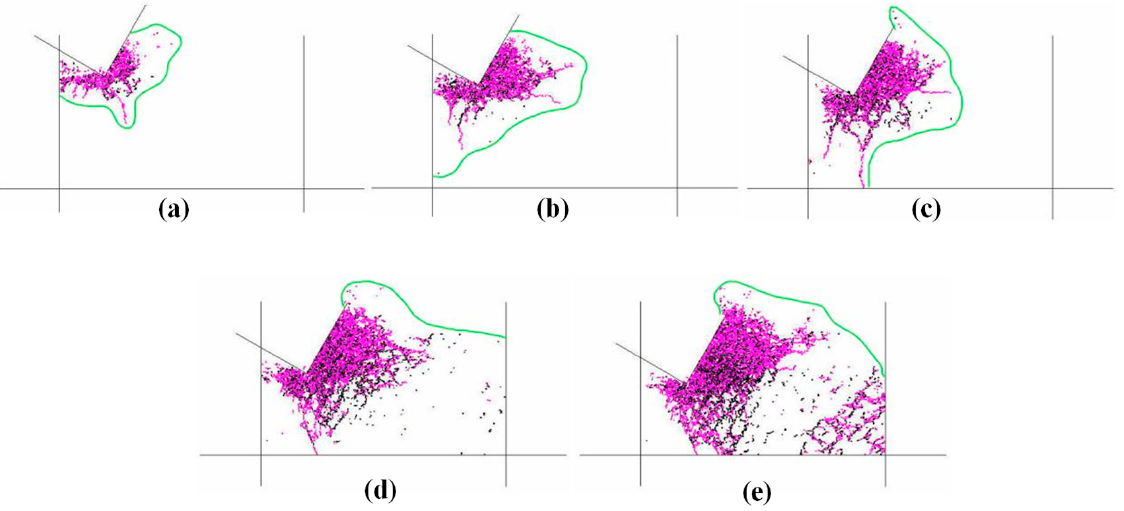
Figure 16. Schematic diagram of crack distribution of specimens with different cutting depths: ( a ) 5 mm; ( b ) 10 mm; ( c ) 15 mm; ( d ) 20 mm; ( e ) 25 mm. (Purple represents shear crack, black represents tensile crack, and the range of green curve envelope represents crack growth area.)